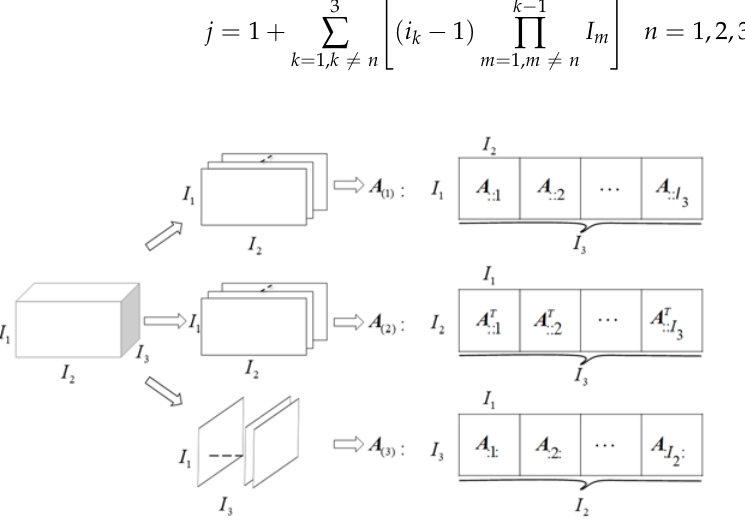
Figure 1. Unfolding of the third-order tensor.